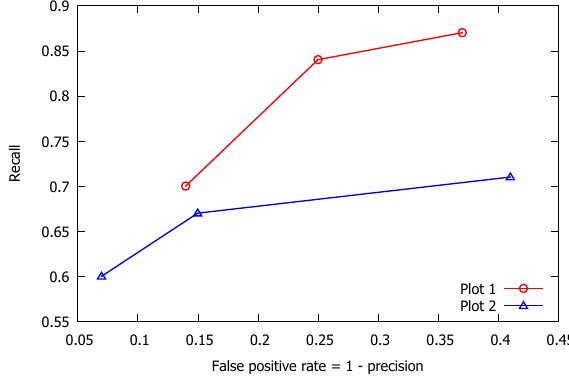
Figure 7. Single tree stem detection performance with probability threshold of 0.4 to 0.6 for the test